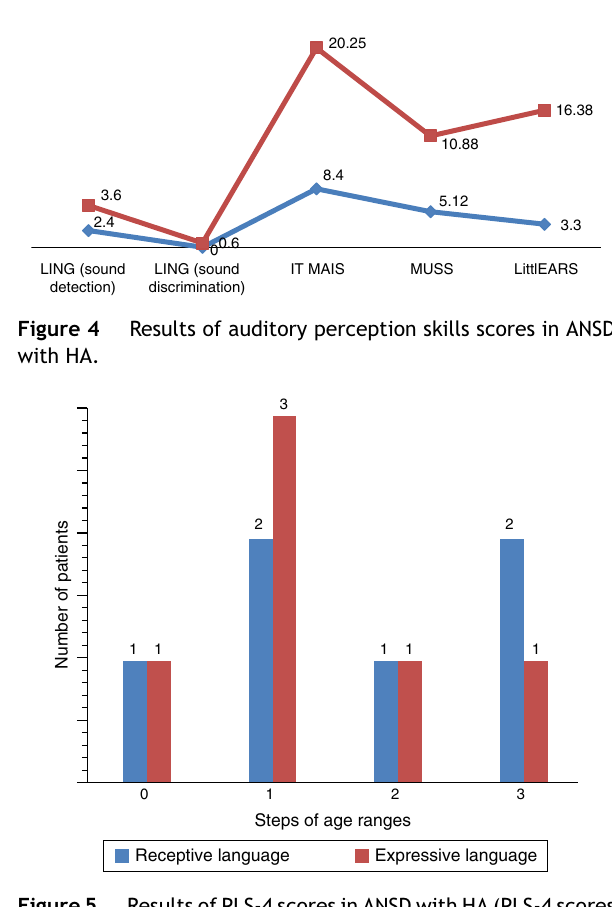
Figure 5 Results of PLS-4 scores in ANSD with HA (PLS-4 scores were shown as progress in age range by